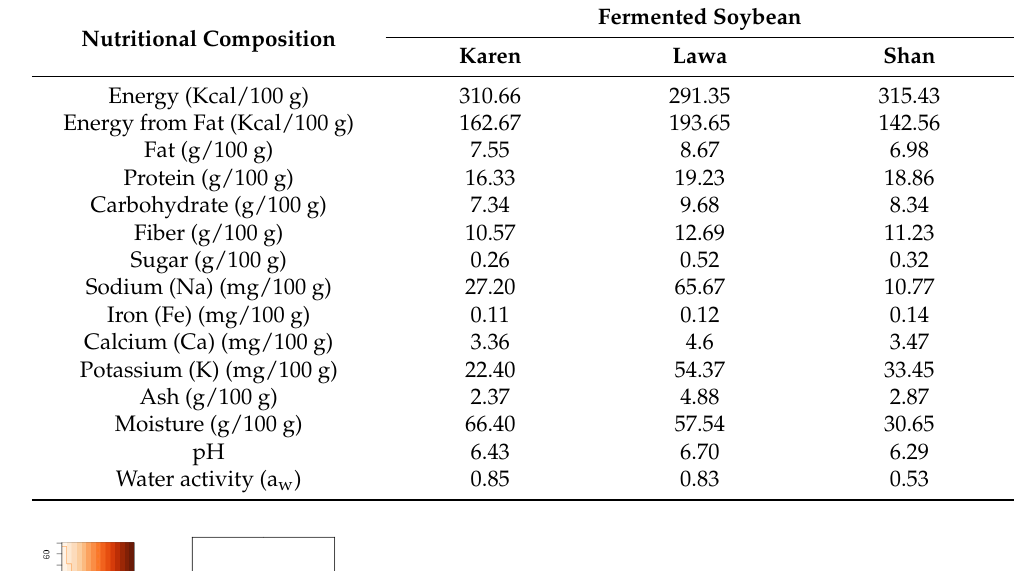
Table 1. Nutritional compositions of fermented soybean products from three ethnic groups.